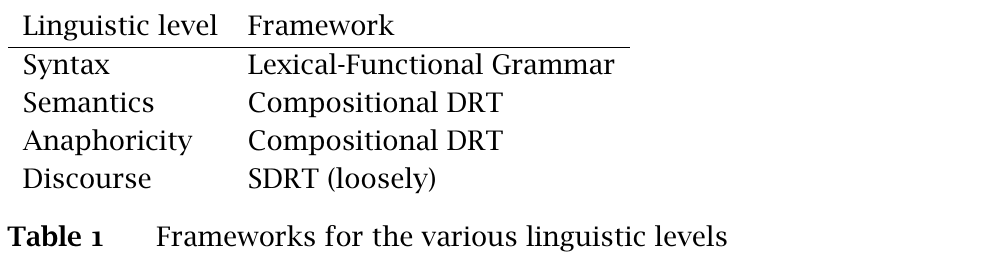
Table 1 Frameworks for the various linguistic levels reasoning over EDUs. This means that in SDRT a single sentence can give rise to multiple DRSs (or formulae of another dynamic language), whereas